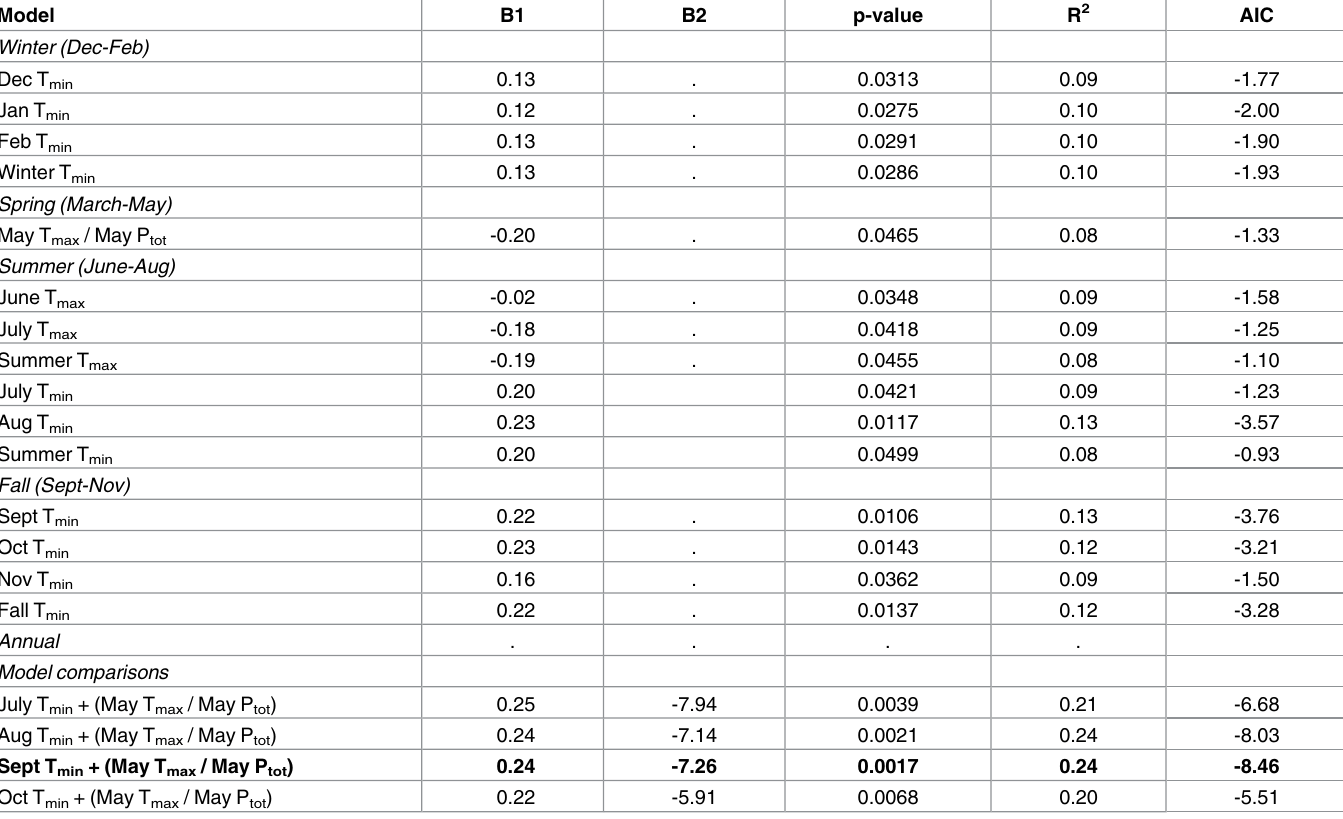
Table 2. Summary of significant climate models tested and the corresponding statistics for each. Tmin, Tmax and Ppt represent average minimum temperature, maximum temperature and total precipitation for 30-year climate normals (1981–2010). All significant results for individualmonths and sea- sonal averages are shown. B1 and B2 show regressioncoefficients for the first and second, if present, independent variable. The final model is shown in bold.